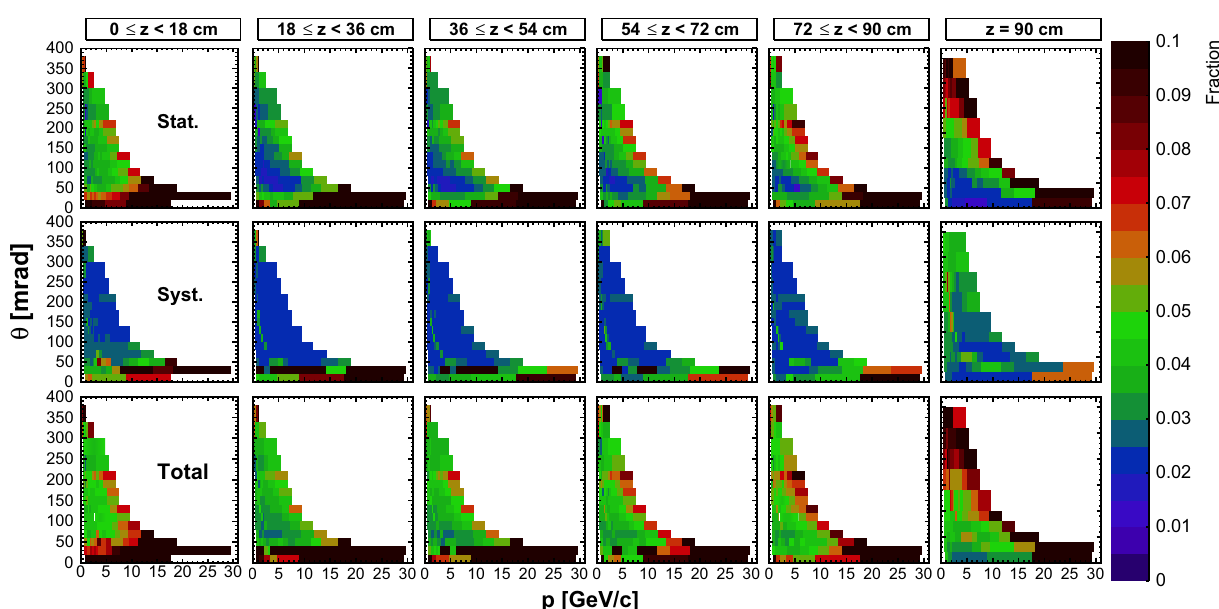
Fig. 18 Uncertainties on π − yields shown as a function of p and θ : statistical uncertainties (top row), total systematic uncertainties (middle row) and total uncertainties (bottom row). Each column corresponds to a different longitudinal bin